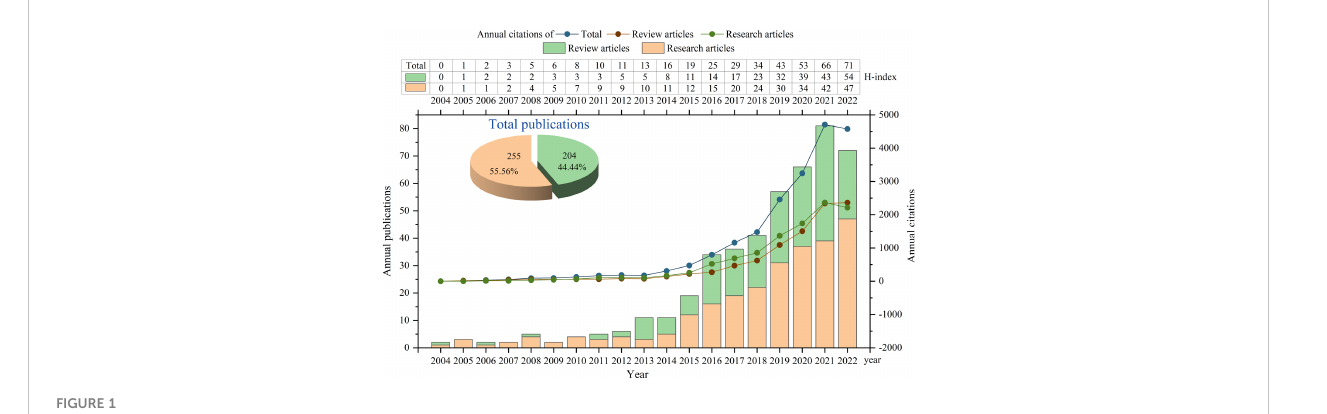
FIGURE 1 Quantities and trend of publications output and annual citations of GM in RA from 2004 to 2022.